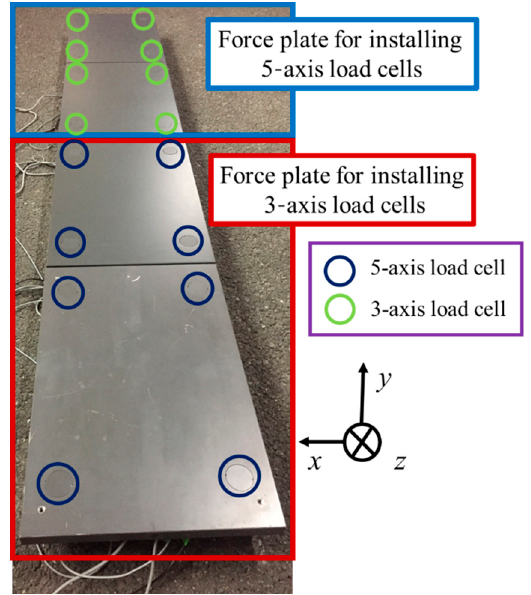
Figure 2. Experimental view and the position of load cells in force plates. The force plates were installed in a straight line, and the height between force plates were adjusted by using a special adjuster by screw bolt mechanism.